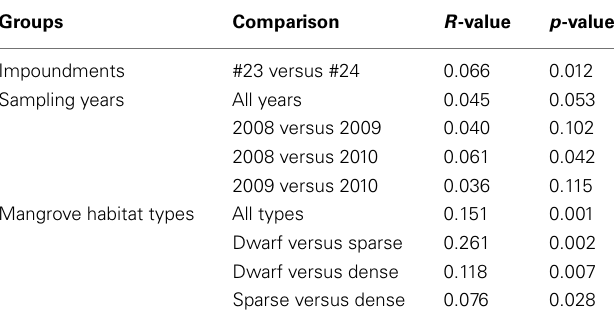
Table 3 | Pair-wise similarities among communities of ammonia- oxidizing betaproteobacteria as obtained from an analysis of similarity (ANOSIM) between impoundments, sampling years, and habitats of Black